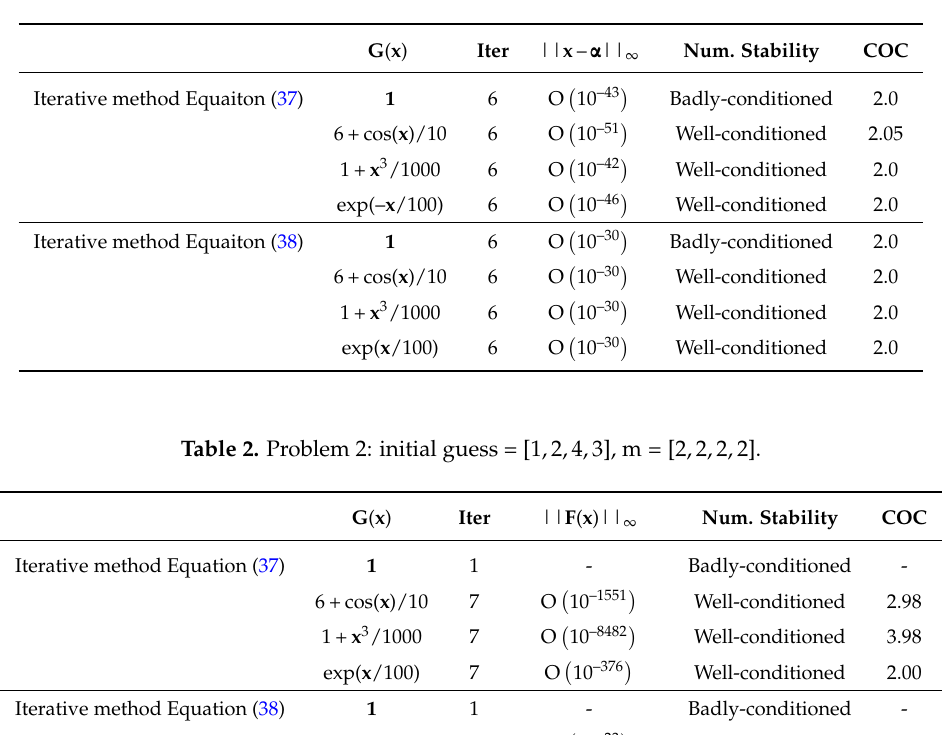
Table 1. Problem 1: initial guess = [2,1,–2], m = [4,5,6].